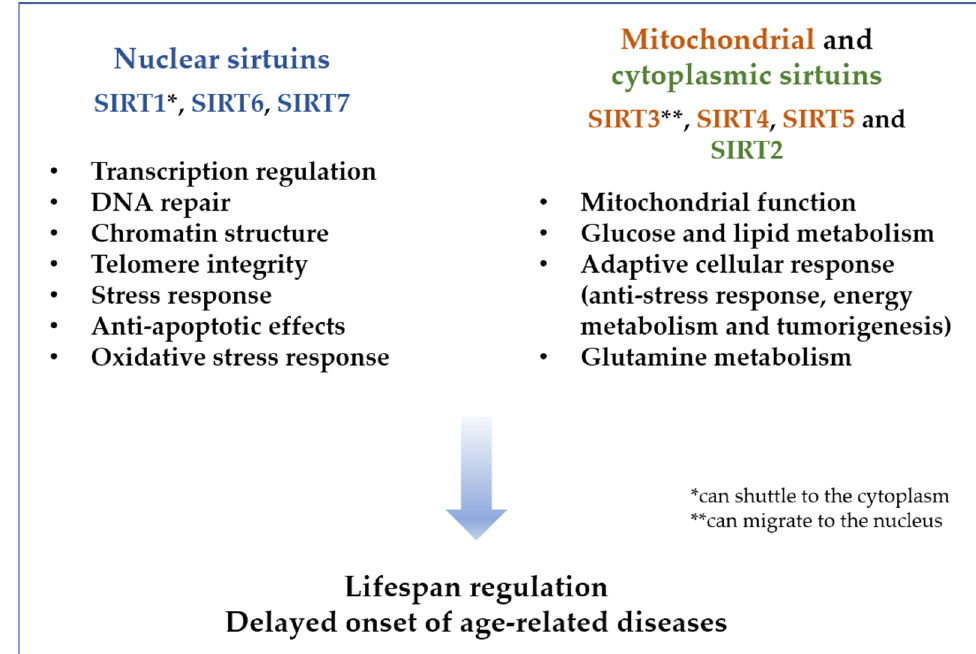
Figure 3. Processes regulated by